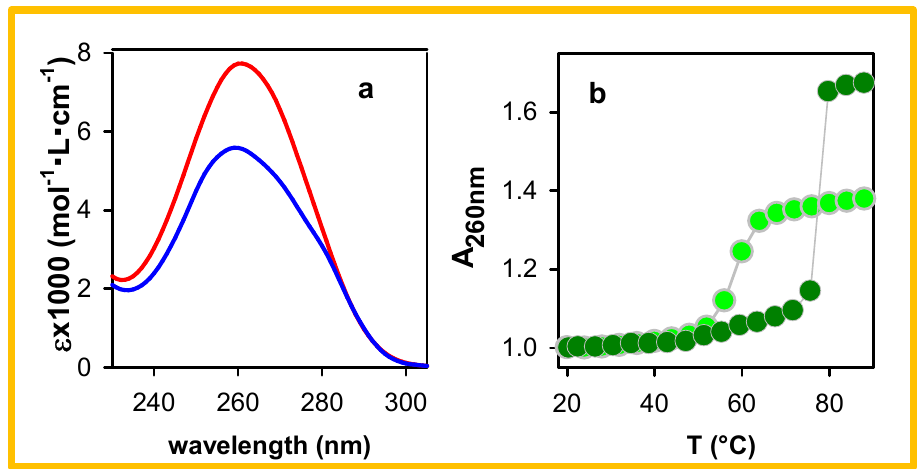
Figure 7. ( a ) Steady state absorption of A 20 T 20 at 20 °C (blue) and 92 °C (red); ε values (per base) were taken from reference [34]. ( b ) Melting curves determined at 260 nm for A 20 T 20 (light green) and pA pT (dark green).